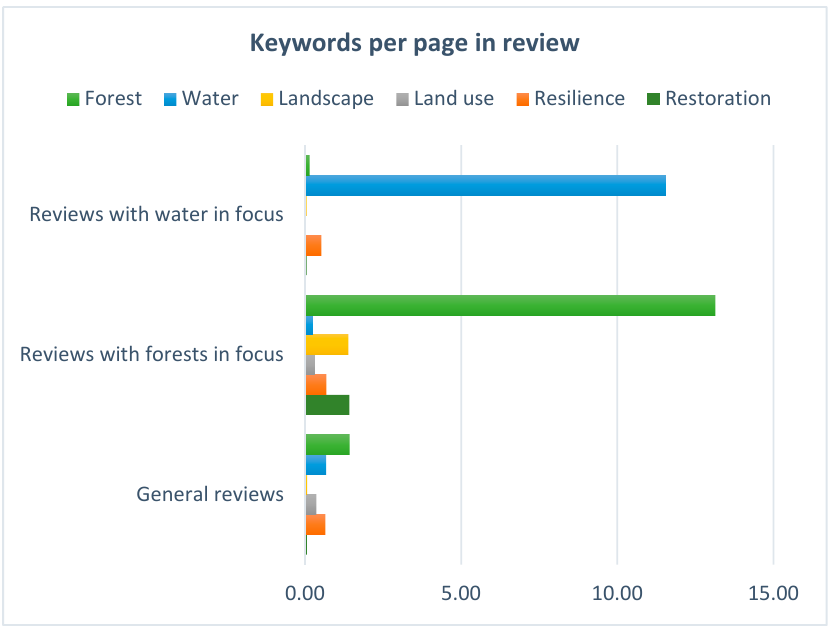
Figure 4. A synthesis of (I)NDC reviews illustrating the lack of integrating the forest–water nexus into the (I)NDCs.